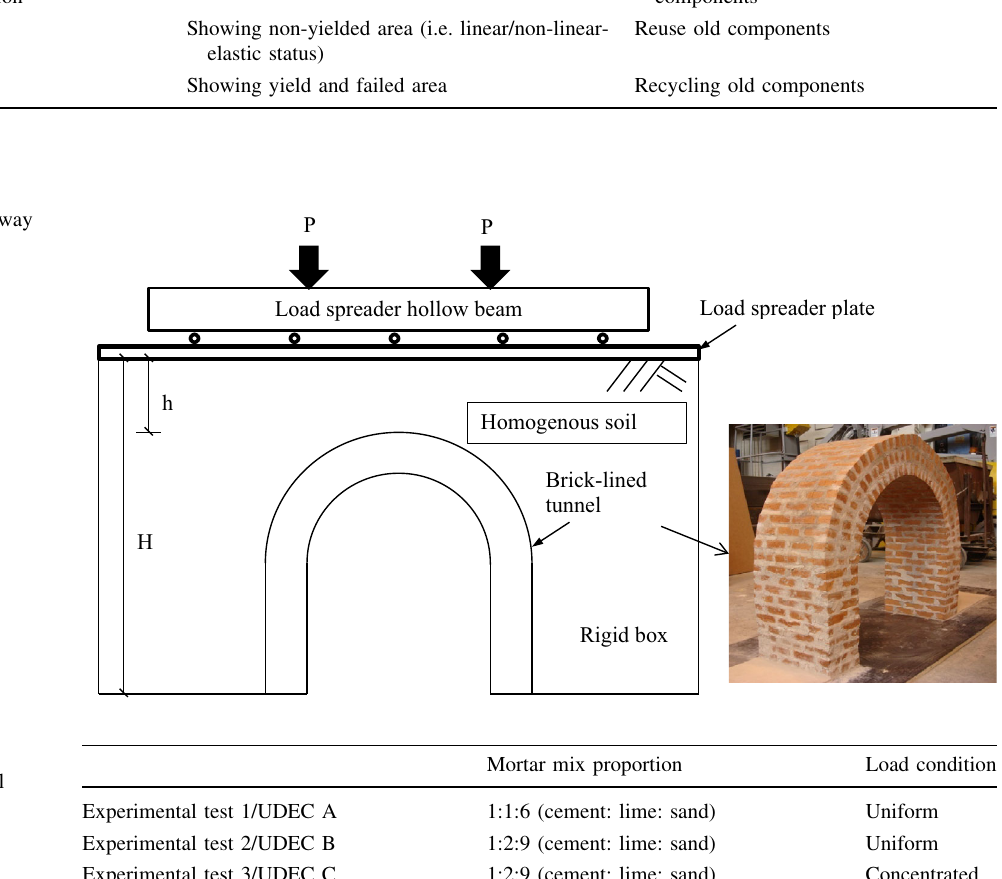
Table 3 Variations for experimental and numerical